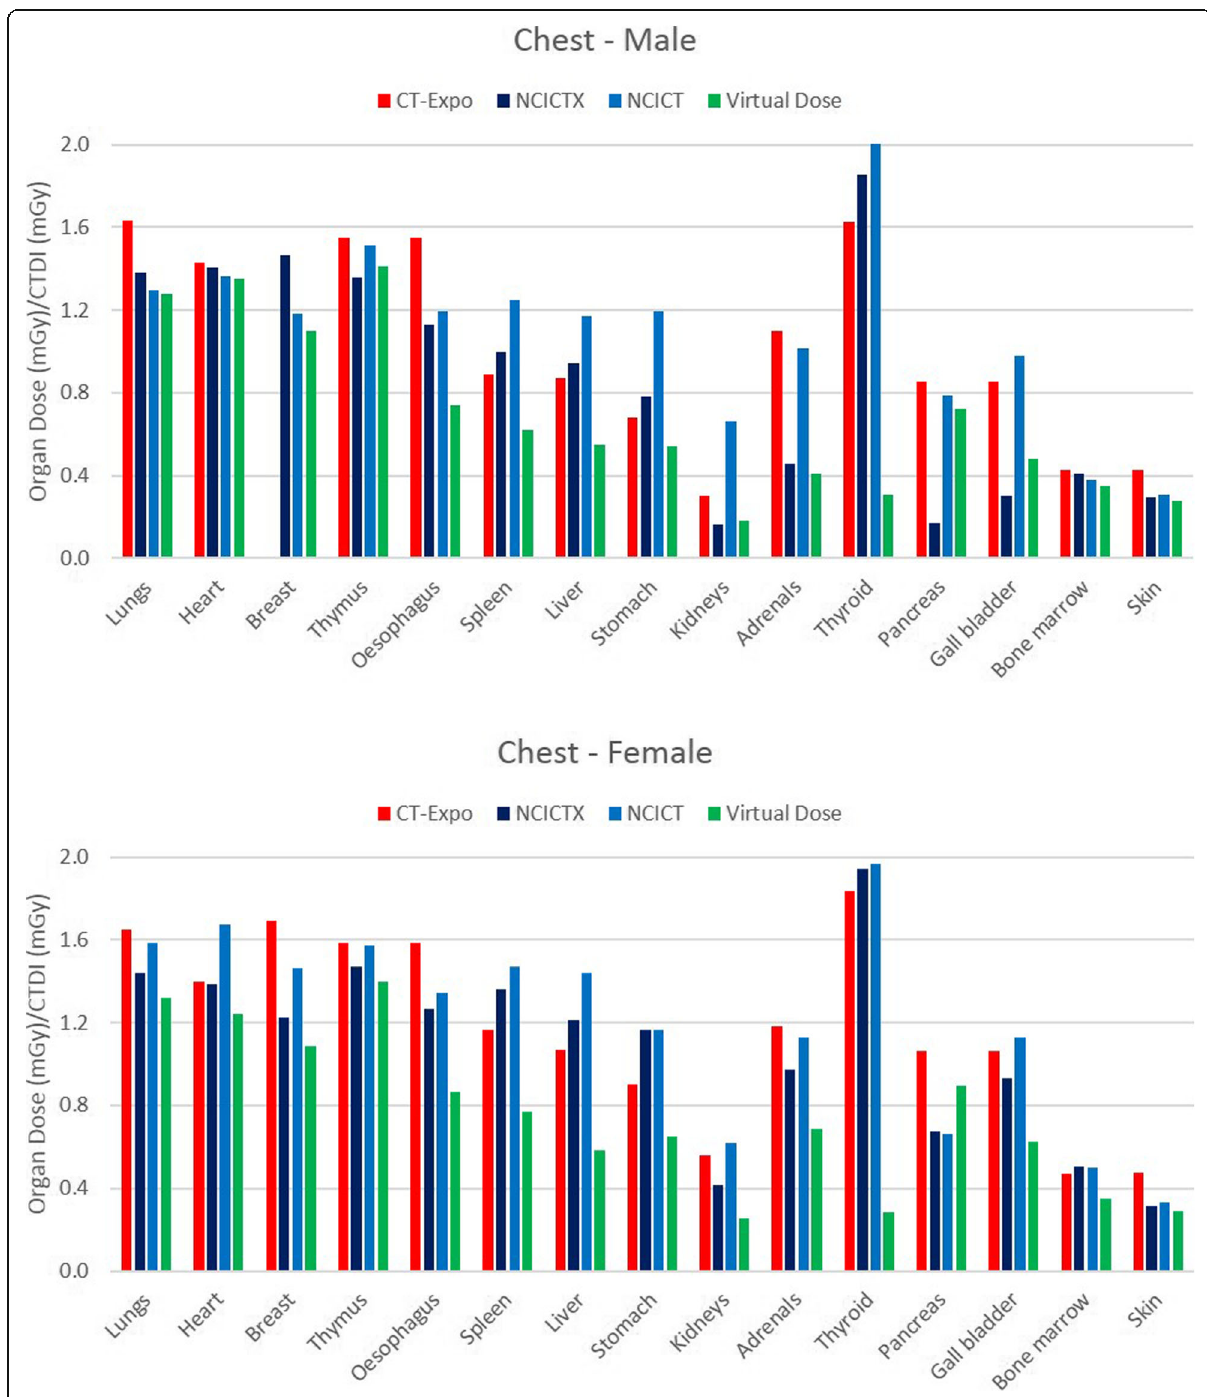
Fig. 4 Organ dose per volume computed tomography dose index (CTDI vol ) unit, obtained simulating the CT Chest protocol with CT-Expo, NCICTX, NCICT, and Virtual Dose, using a male and female phantom. These values are dose coefficients, obtained as organ dose (mGy) and CTDI vol (mGy) ratio. Lungs, heart, breast, thymus, oesophagus, and spleen are completely irradiated. CT-Expo considers the breasts only for the female